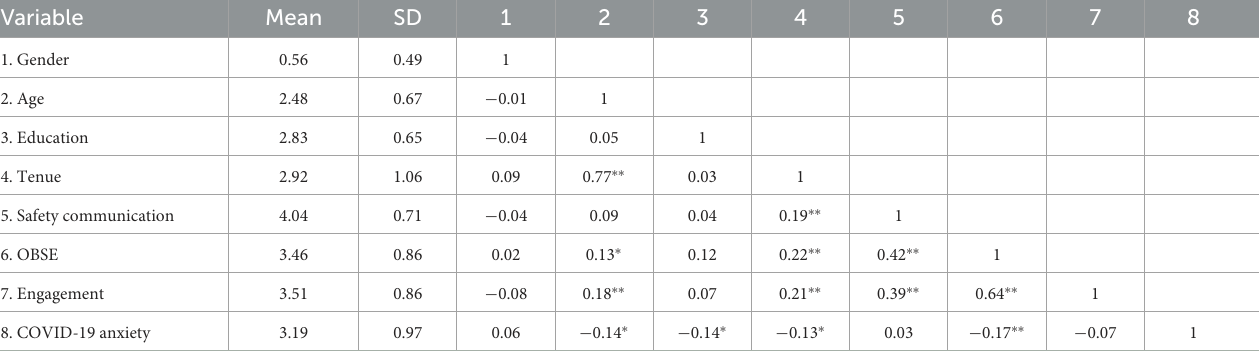
TABLE 2 Descriptive statistics and